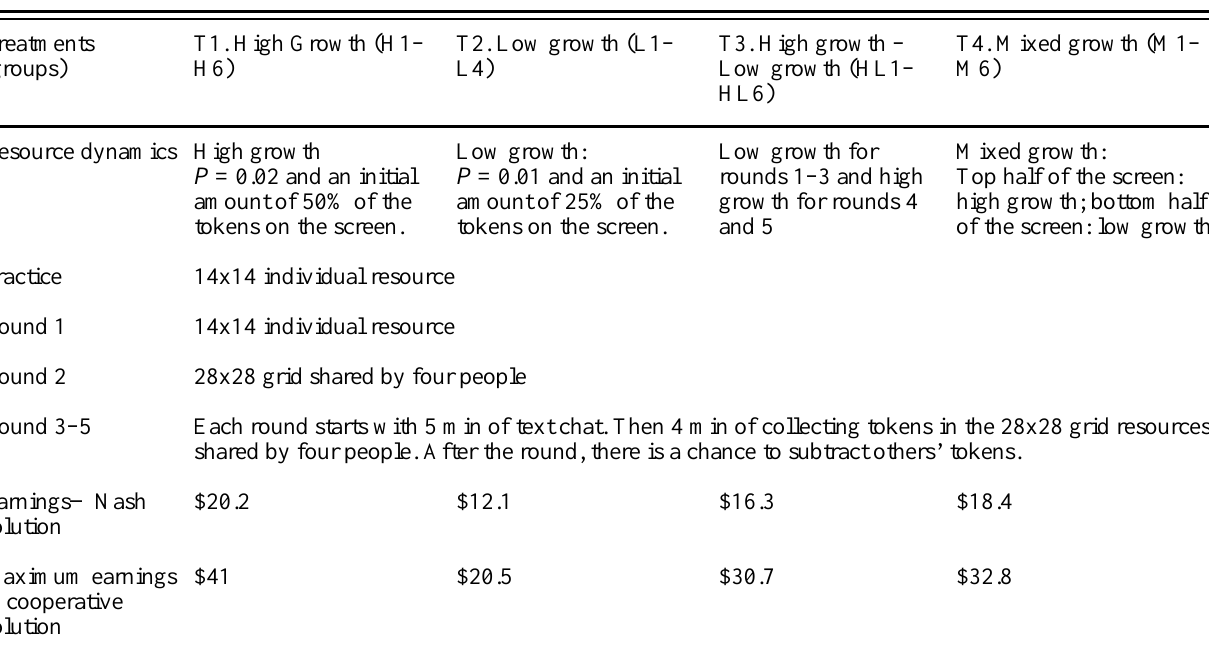
Table 1. The four experimental treatments. Note: The label for the groups is given in parentheses. Treatments (groups) Resource dynamics High growth P = 0.02 and an initial amount of 50% of the tokens on the screen.